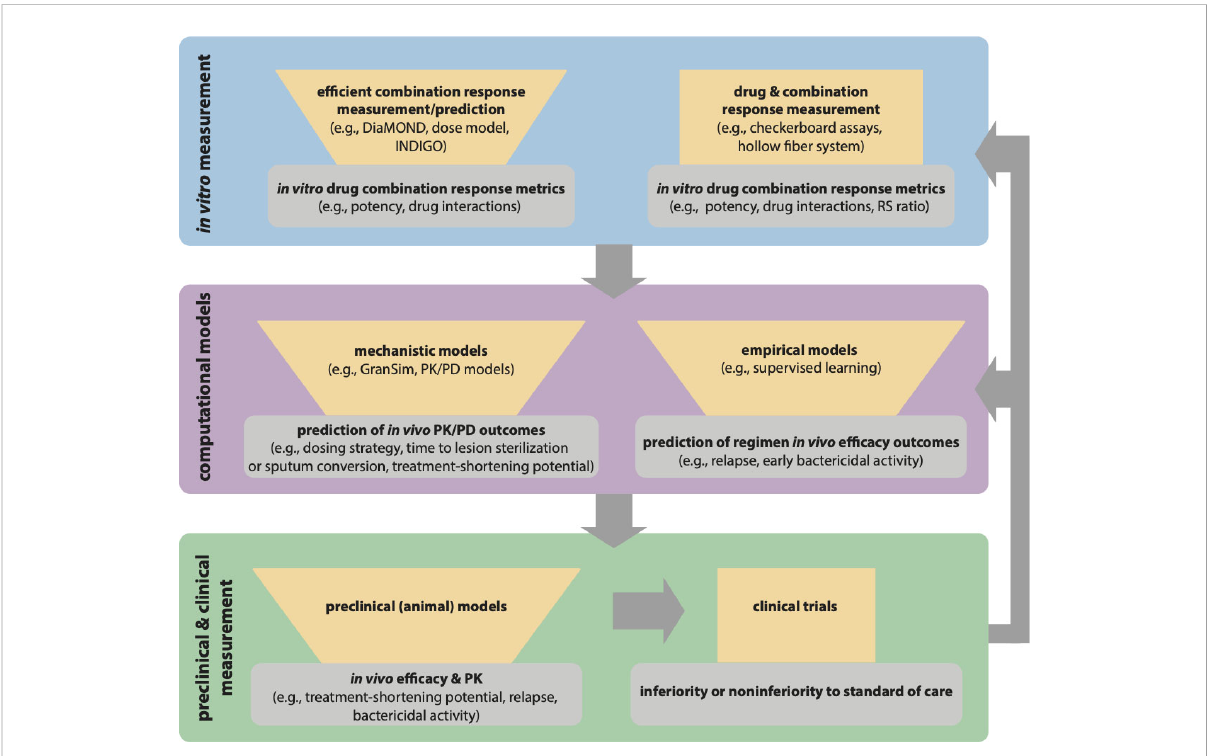
FIGURE 2 Paradigm for iterative modeling of drug combinations using in vitro and computational tools to reduce the drug combination space for in vivo testing and clinical trials. Each iterative step of drug combination design should reduce the number of combinations or regimens to test in the next step (represented with funnels). The tools in the in vitro exploration space (blue) allow for exhaustive combination screens while requiring fewer measurements. Specialized tools like the hollow fi ber system allow for in vitro PK/PD exploration. The output of in vitro models is input into computational models (purple) for empirical prediction of in vivo ef fi cacy and used with in vivo PK study data in mechanistic predictions of in vivo PK/PD outcomes. The best combinations from model predictions can then go back to the in vitro space (blue) for expanded testing (e.g., with different Mtb strains, different culture conditions), and the prioritized combinations from expanded in vitro testing would be input again through computational models (gray arrows). The best regimens from model predictions are tested in preclinical models (green), and the best regimens from preclinical models can go back to in vitro exploration and computational models for further re fi nement of the models and experimental design (gray arrows). Iterative improvement of regimens allows for optimized combinations to go to clinical